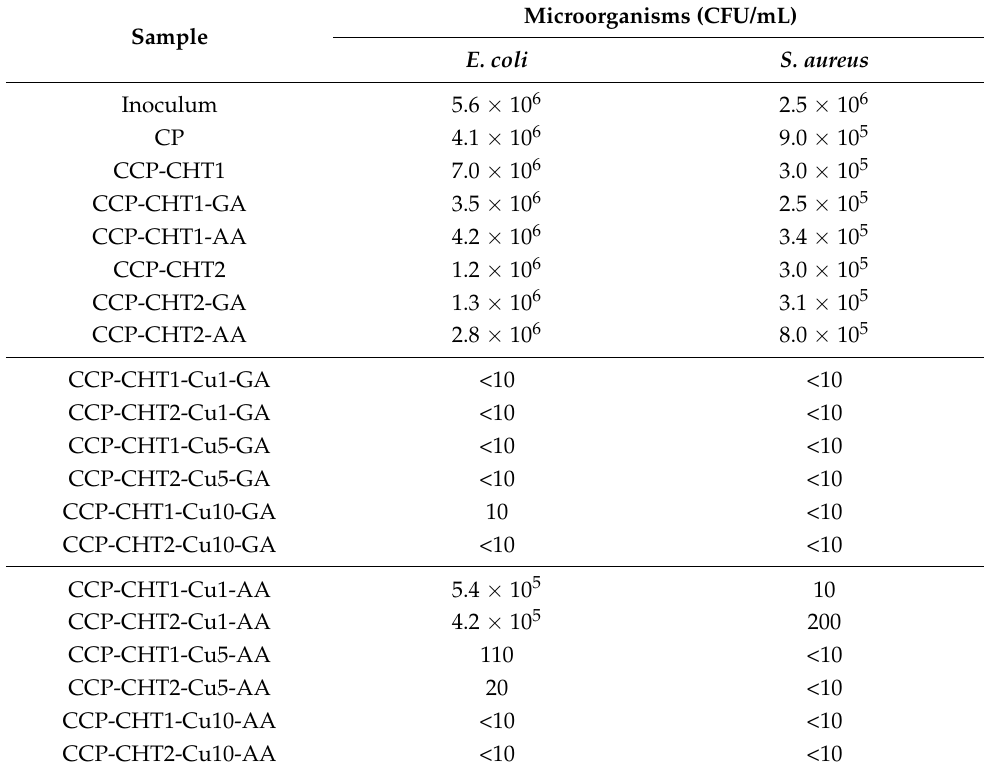
Table 4. Antimicrobial activity of investigated